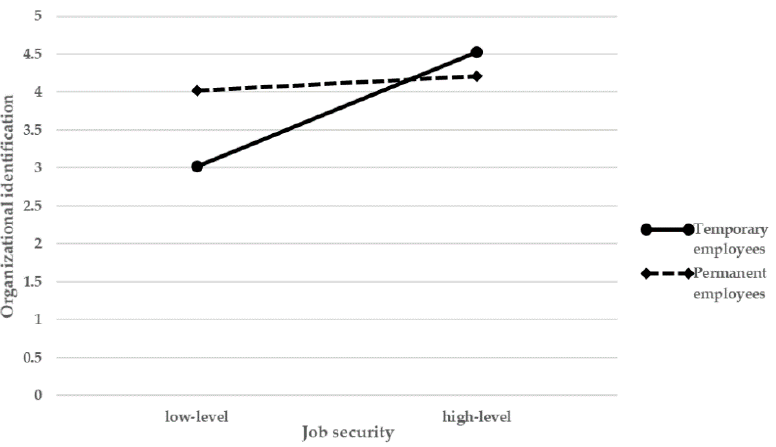
Figure 2. Interaction between job security and employment status on organization identification.